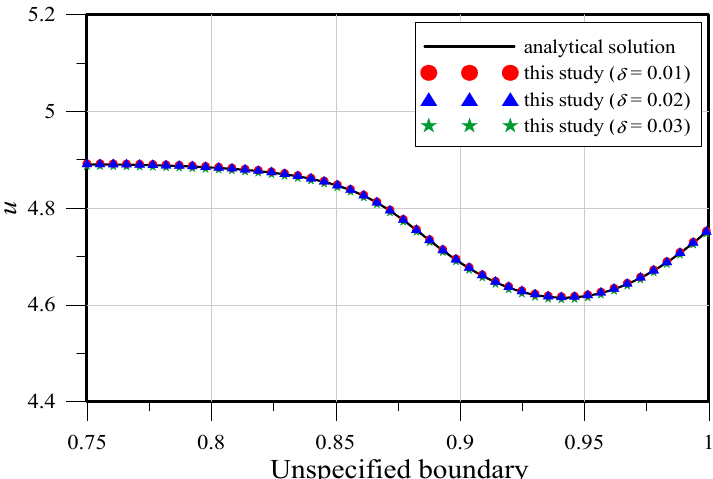
Figure 14. Error versus the noise level: ( a ) case A. ( b ) case B.